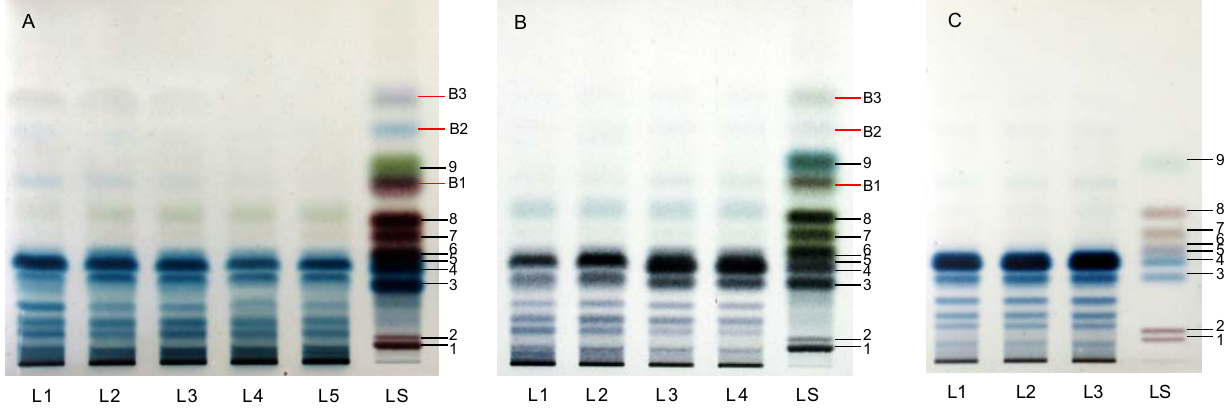
5 mol/L, and ( C ) optimum conditions (5 mol/L for 6 h) on acid hydrolysis of polysaccharides from Ganoderma lucidum (GL07). A : L1, 7 mol/L; L2, 6 mol/L; L3, 5 mol/L; L4, 4 mol/L; L5, 3 mol/L. B : L1, 2 h; L2, 4 h; L3, 6 h; L4, 8 h. C : L1, L2 and